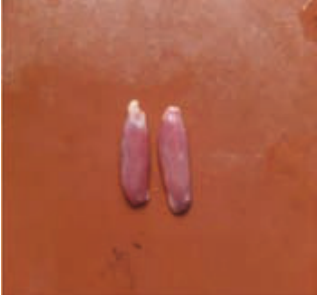
Fig. 1. Gel electrophoresis showing 630 bp amplicons of VP2 gene of canine parvo virus. Lane 1 : 100 bp DNA ladder ; Lane 2 : Positive control; Lane 3 to 6 : Samples; Lane 7 : Negative control